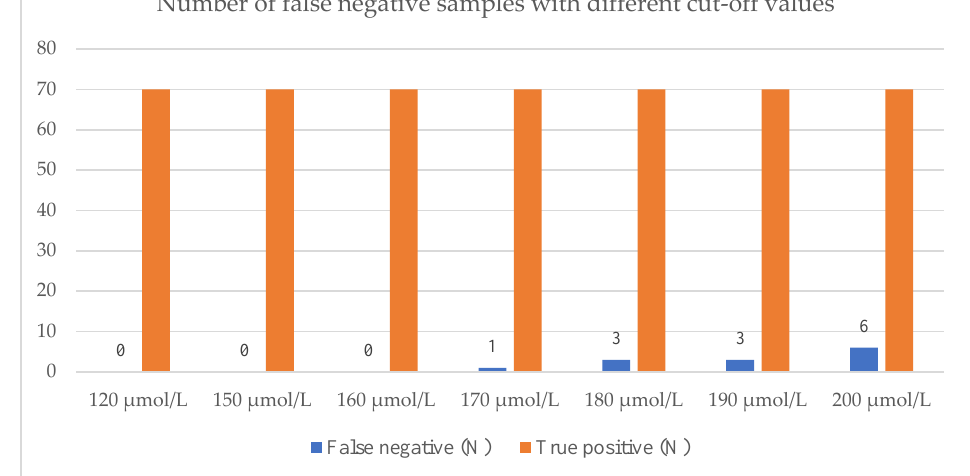
Figure 3. The number of false negatives with different cut-off values.